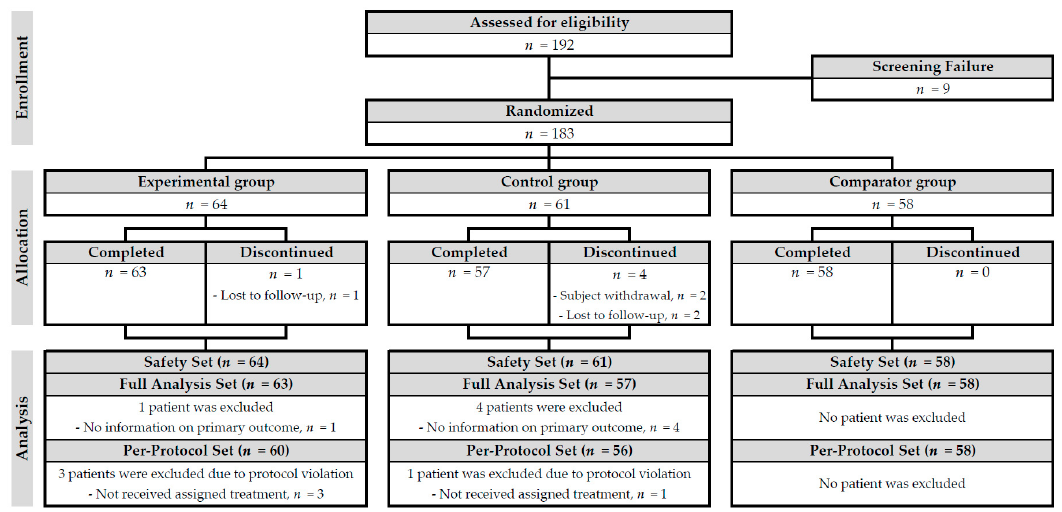
Figure 1. Flow diagram of the progress through the phases of a parallel randomized trial.